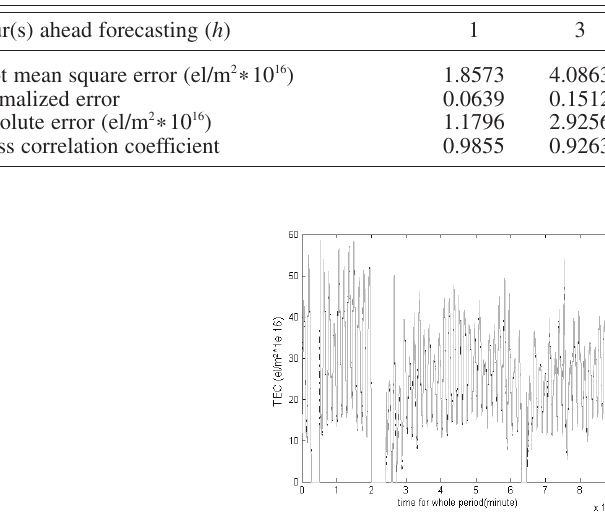
Table 16.II. Error